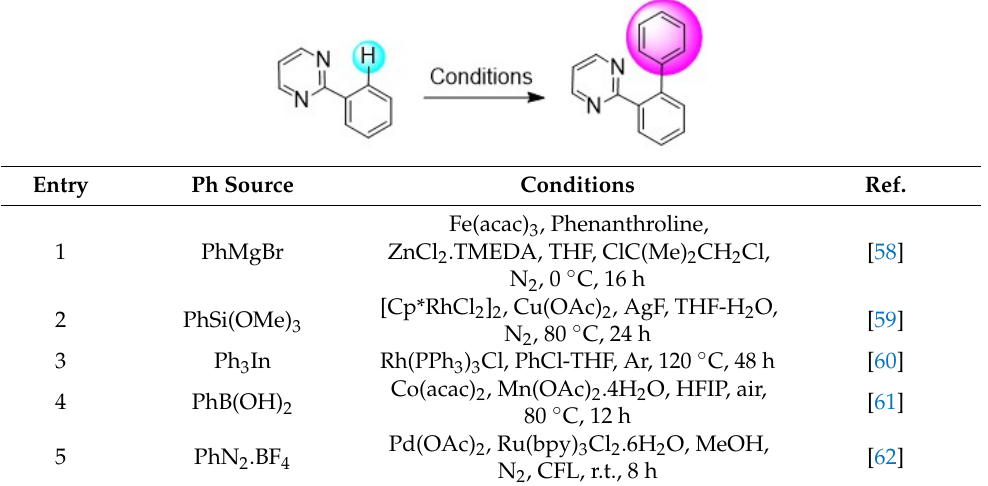
Table 1. Synthetic methods previously reported for the N -directed C–H arylation of simple, unsubstituted 2-phenylpyrimidines.